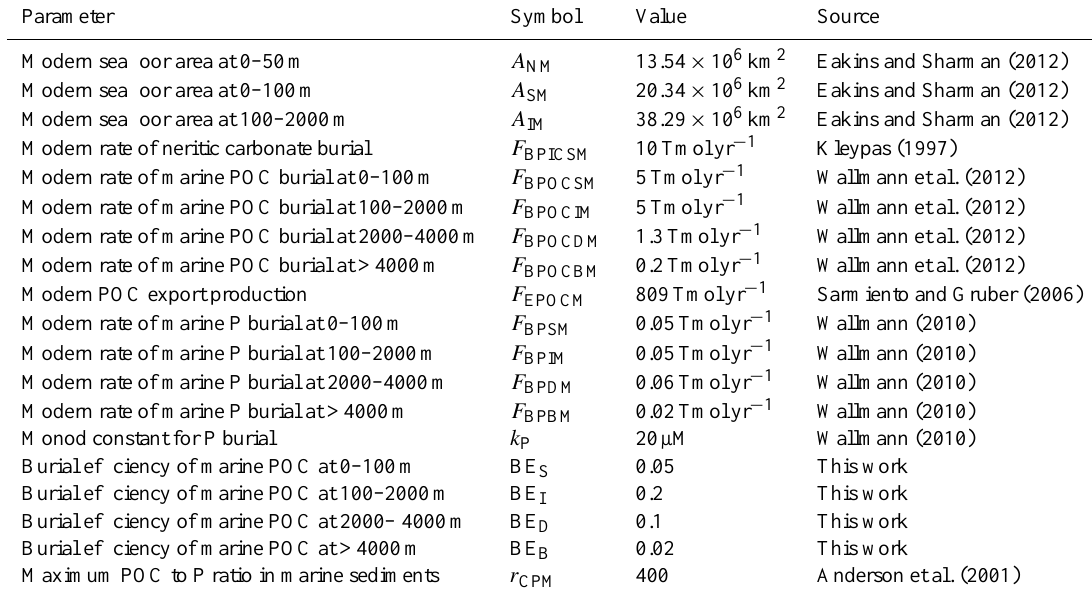
Table B1. Parameter values applied in the simulation of margin processes.